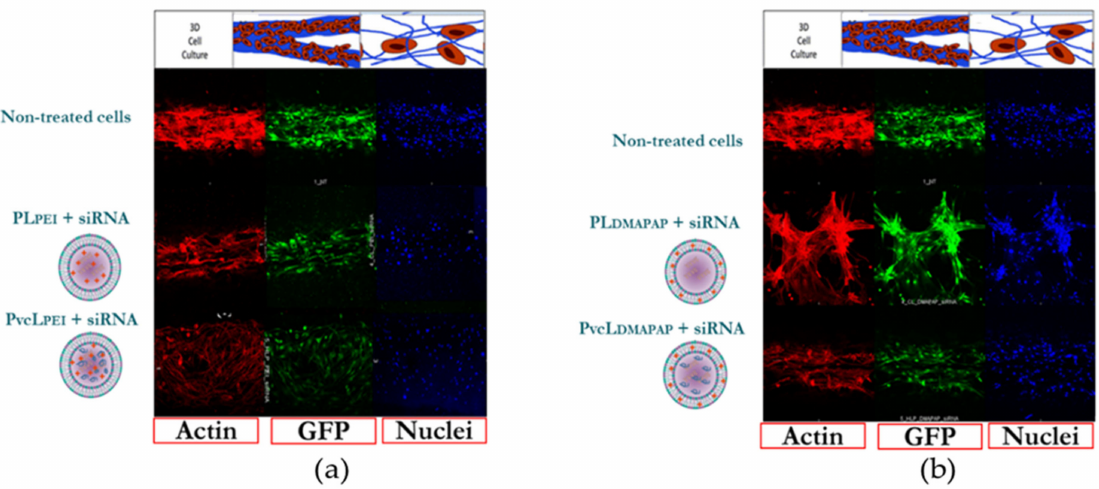
Figure 7. Confocal imaging of endothelial cells in the three-dimensional (3D) culture microchip treated with various formulations in vitro, ( a ) non-treated PL PEI and PvcL PEI ; ( b ) non-treated PL DMAPAP and PvcL DMAPAP treated